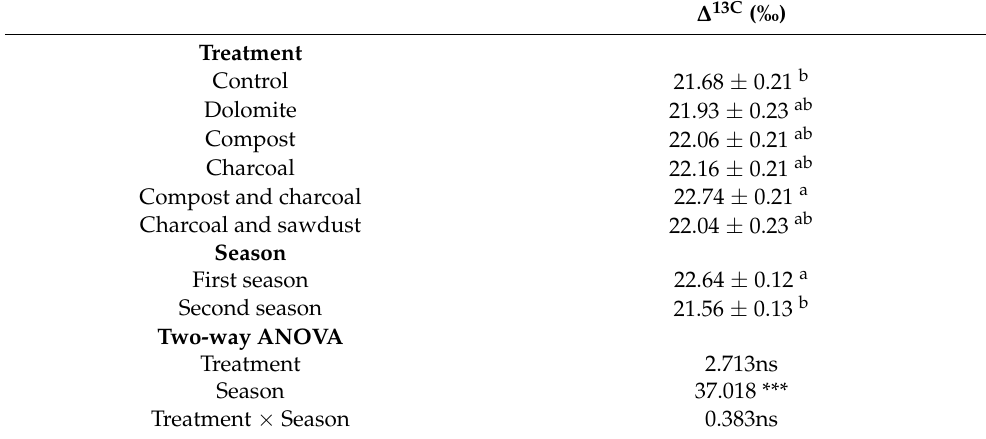
Table 5. Comparison of mean carbon isotope discrimination ( ∆ 13 C) in different soil amendment treatments and season of centrosema. Given are mean ± SE ( n = 4). Different letters indicate significant differences in treatment and season as revealed by two-way ANOVA followed by linear contrast post hoc test with associated p -values for treatment (T), season (S), and their interaction (T × S).